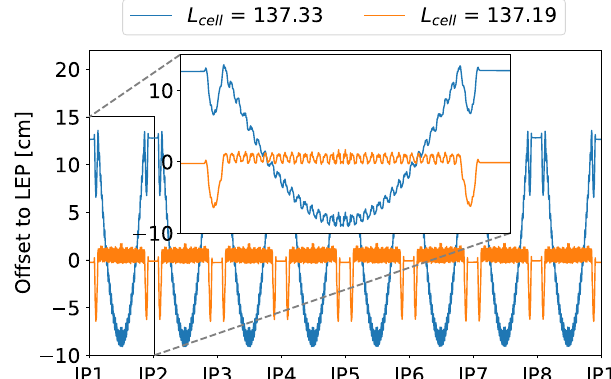
FIG. 10. Effect on the geometry offset with respect to LEP of choosing an optimized cell length of 137.19 m for an 18-cell HE-LHC design, compared with a cell length of 137.33 m.